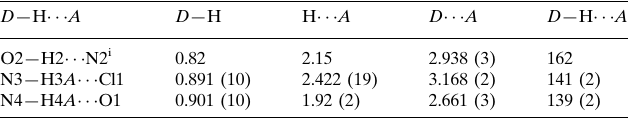
Hydrogen-bond geometry (A˚ , (cid:1)